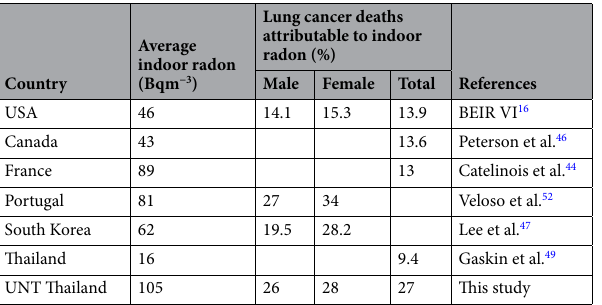
Table 7. Comparison percentage of lung cancer deaths attributable to indoor radon in previous studies using the exposure-age-concentration model (EAC) of BEIR